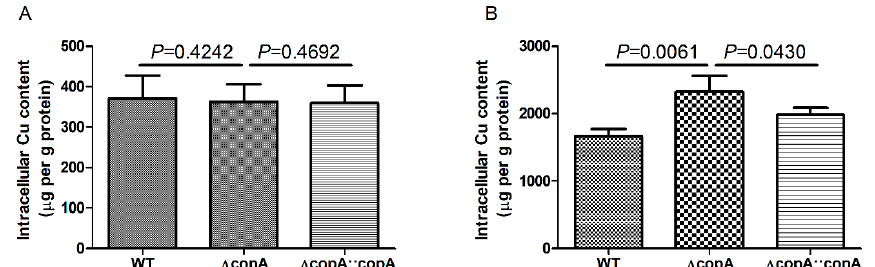
Figure 8. Levels of intracellular copper in the WT, ∆ copA , and ∆ copA :: copA strains. The strains were grown to an OD 600 of 0.3, and then treated with either H 2 O ( A ) or 0.05 mM Cu ( B ) for 2 h. The intracellular copper content was analyzed by inductively coupled plasma-optical emission spectroscopy (ICP-OES). Results represent the means and SD from three biological replicates.